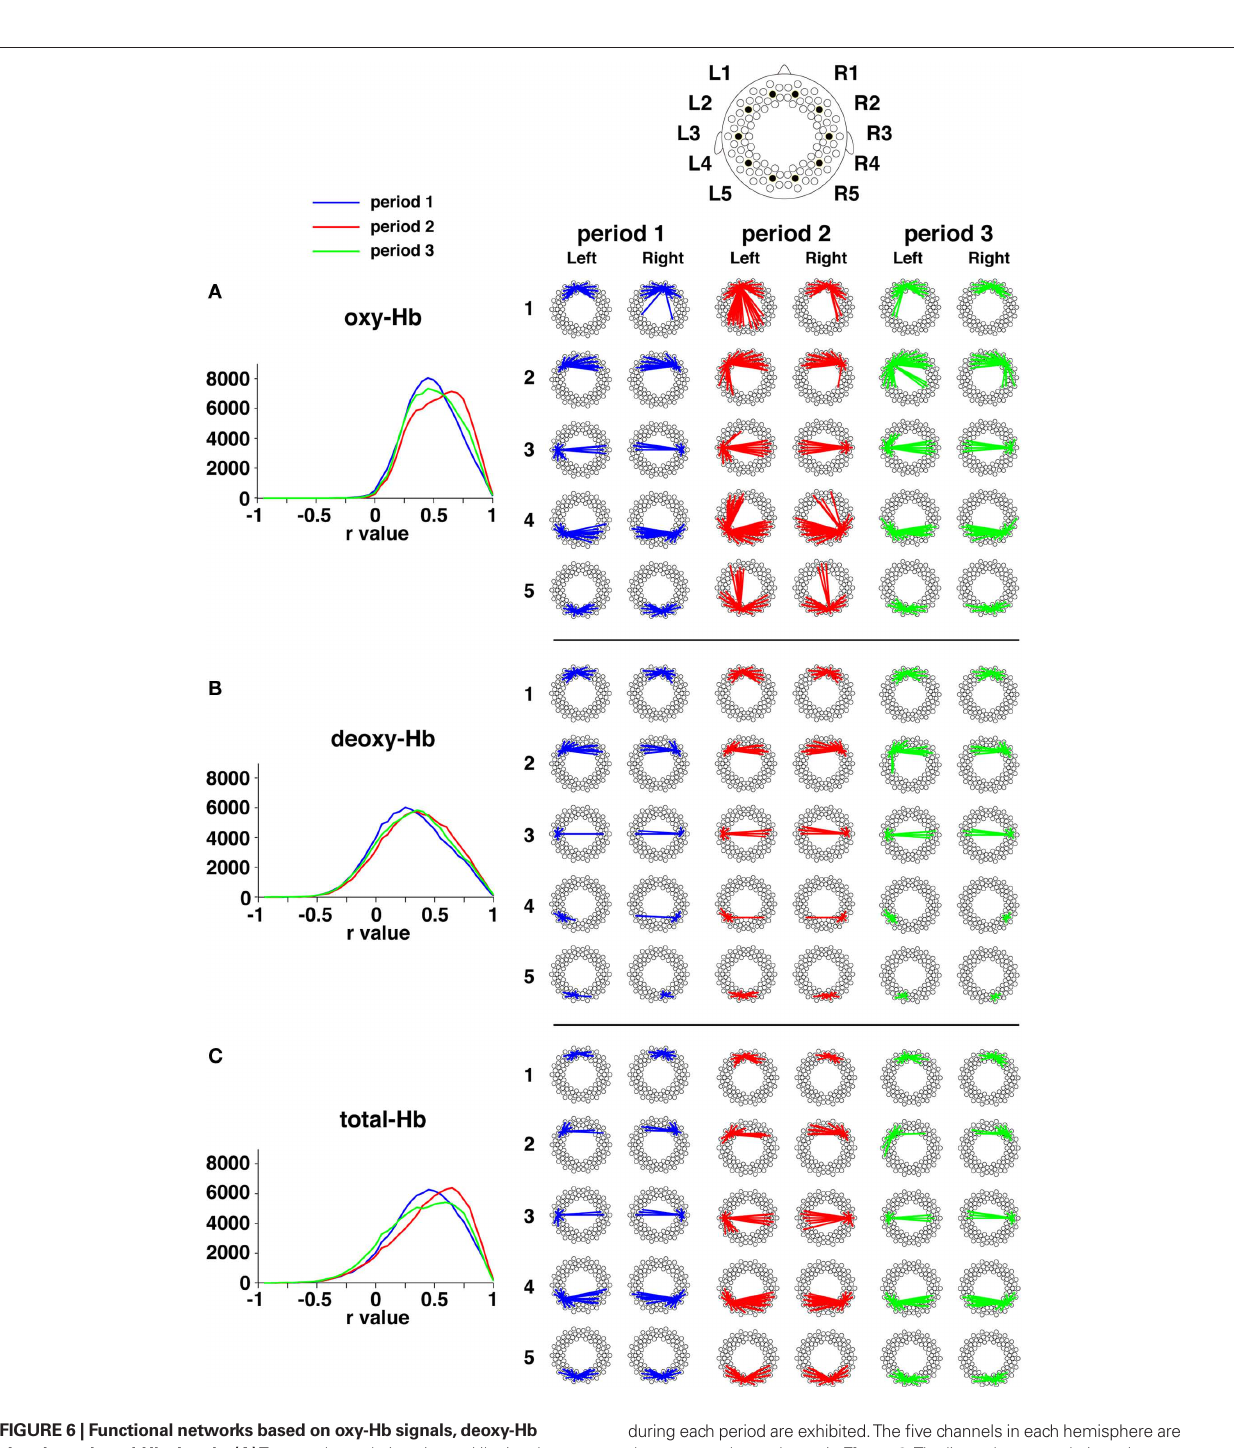
FIguRe 6 | Functional networks based on oxy-Hb signals, deoxy-Hb signals, and total-Hb signals. (A) Temporal correlations in oxy-Hb signals across the three periods. The distributions of correlation coefficients ( r values) are shown by the three lines. The ordinates denote the total number o f c hannel pairs across the infants. The representative correlations